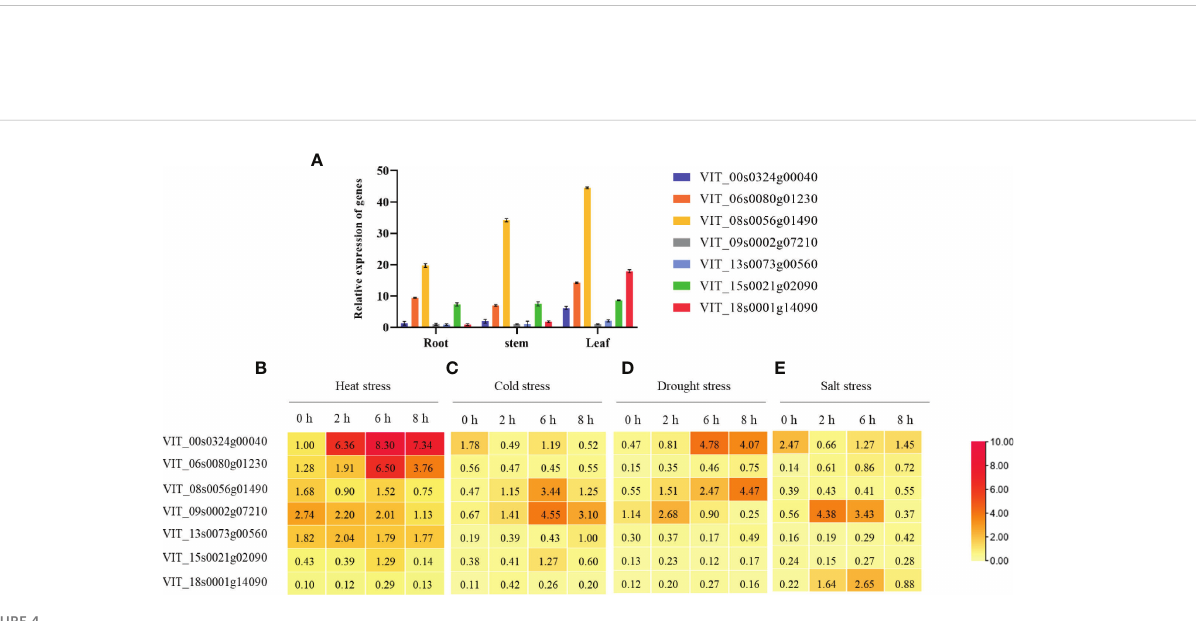
FIGURE 4 Different expression patterns of tissue and reaction by abiotic stresses in grapevine. (A) Tissue expression in root, stem and leaf. After heat stress (B) , cold stress (C) , drought stress (D) and salt stress (E) for 0 h, 2 h, 6 h and 8 h, the different expression pro fi les in grapevine. The results perform the mean ± SE of three independent replicates ( P <